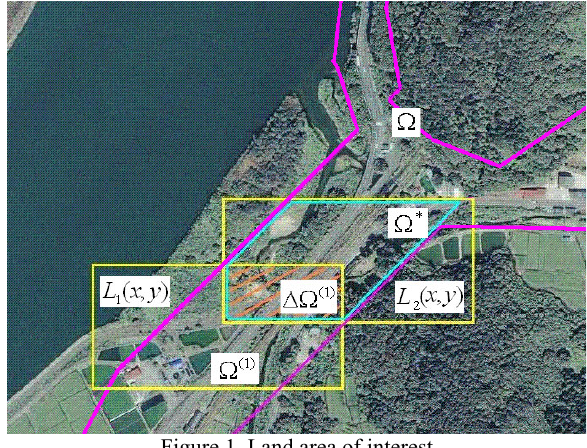
Figure 1. Land area of